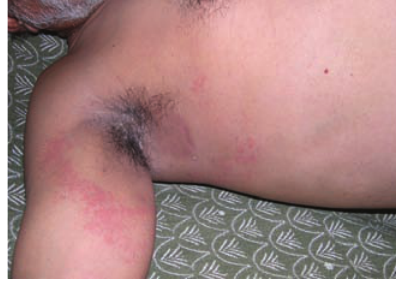
Figure 4. Typical unilateral latero-thoracic exanthema around right axilla in an adult Indian patient.